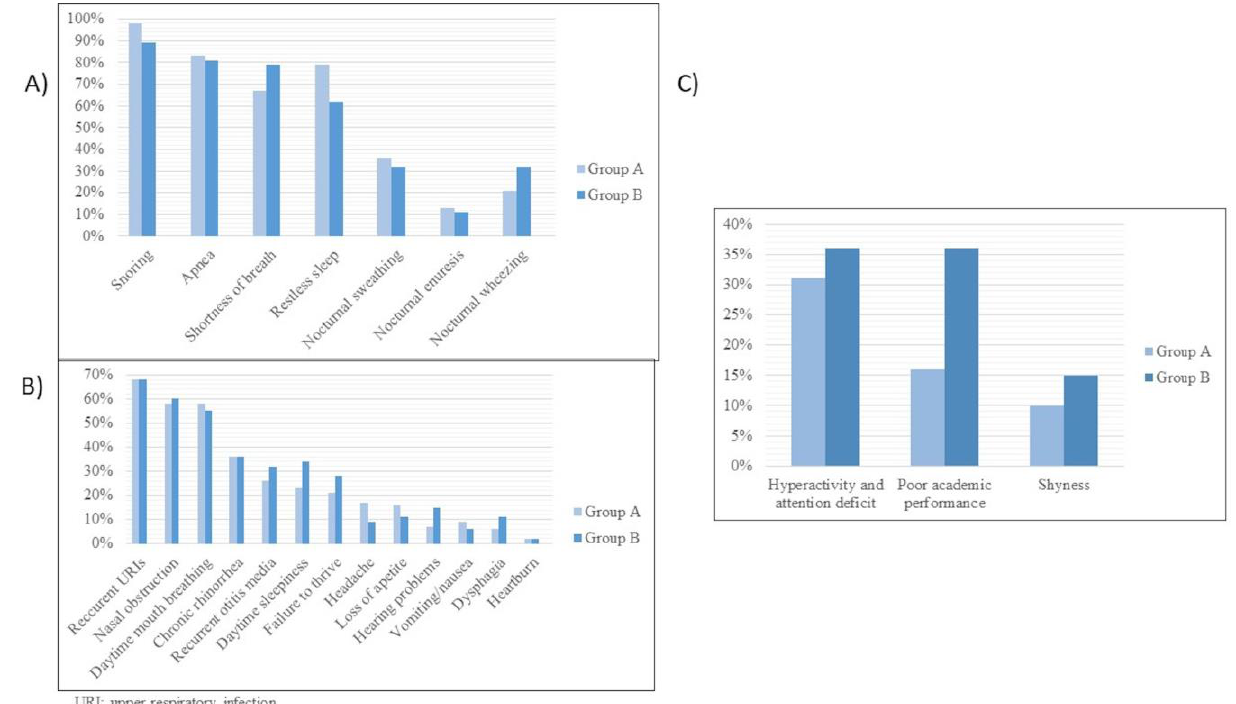
Figure 1. ( A ) Comparison of nocturnal clinical manifestations in Groups A and B. ( B ) Comparison of neuropsychiatric clinical manifestations in Groups A and B. ( C ) Comparison of daytime clinical manifestations in Groups A and B. Table 1. Comparison of age, anthropometric measurements and predisposing factors for sleep apnea–hypopnea syndrome in Groups A and